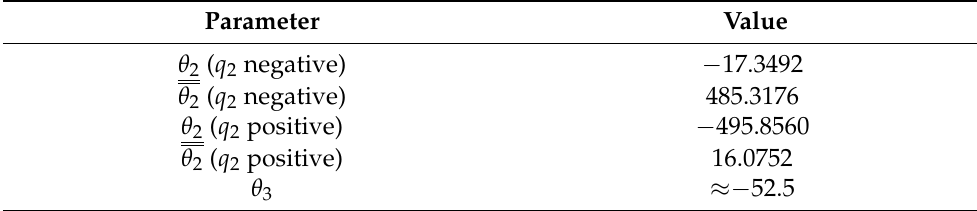
Table 2. Link 2 embedded parameters max. and min.